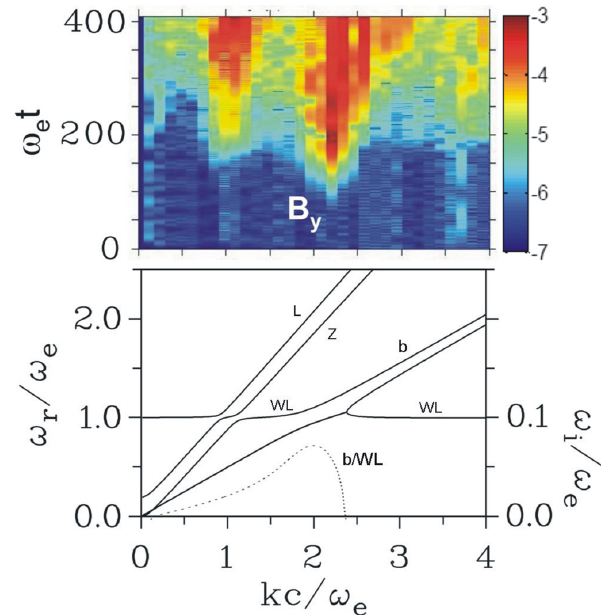
Fig. 11. Temporal evolution of the magnitude of the magnetic field component B y (logarithmic scale) versus wave number (on top) and related linear dispersion (on bottom). Solid curves represent the real part of frequency; the dotted curve indicates the growth rate. The maximum intensity of B y at kc/ω e ∼ 2 . 2 in the upper color plot results from resonant beam-plasma interaction. At ω e t ≥ 200, a second maximum appears near kc/ω e = 1 and begins the accumu- lation of wave energy at the Gendrin point which is related to the formation of whistler-Langmuir